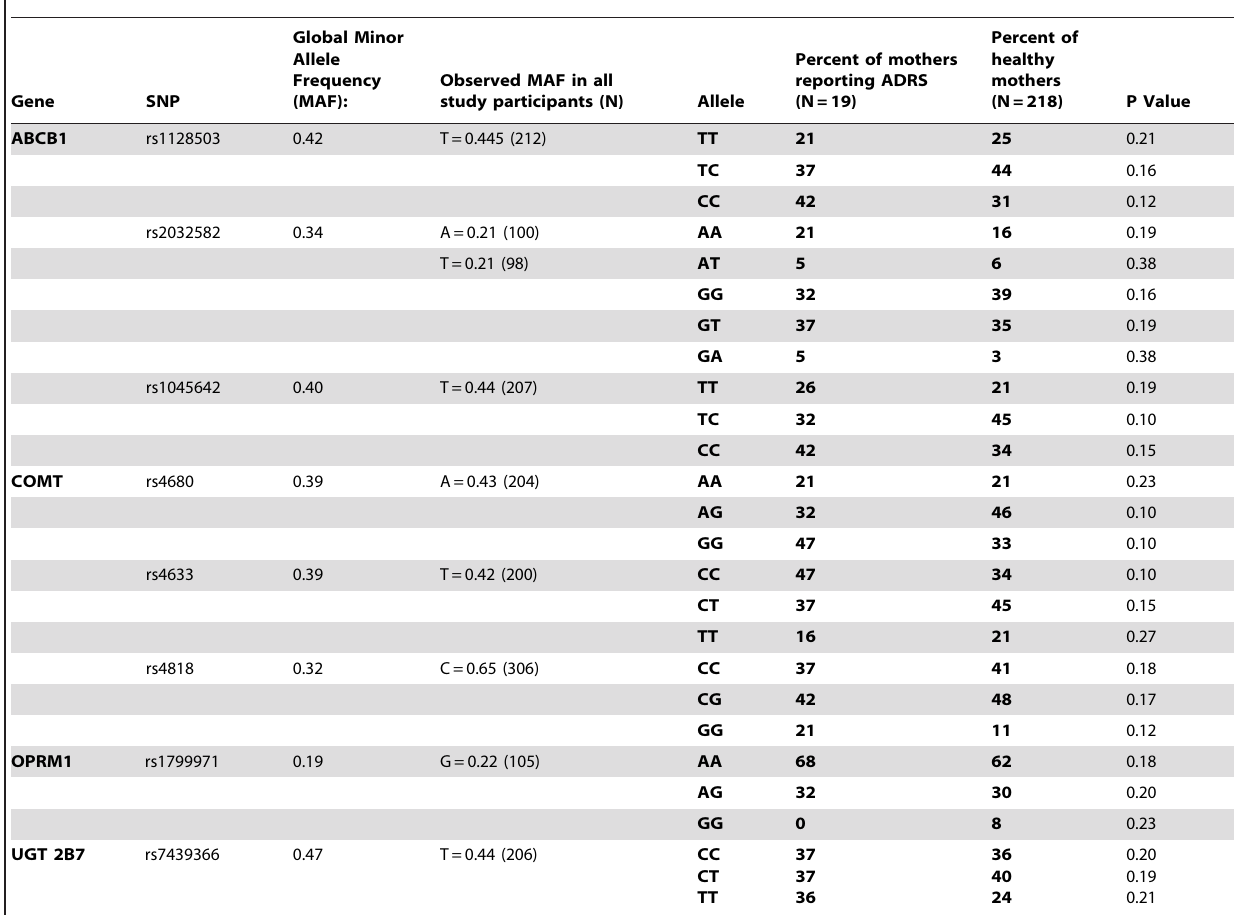
Table 3. The influence of genetic factors on reported maternal adverse effects.